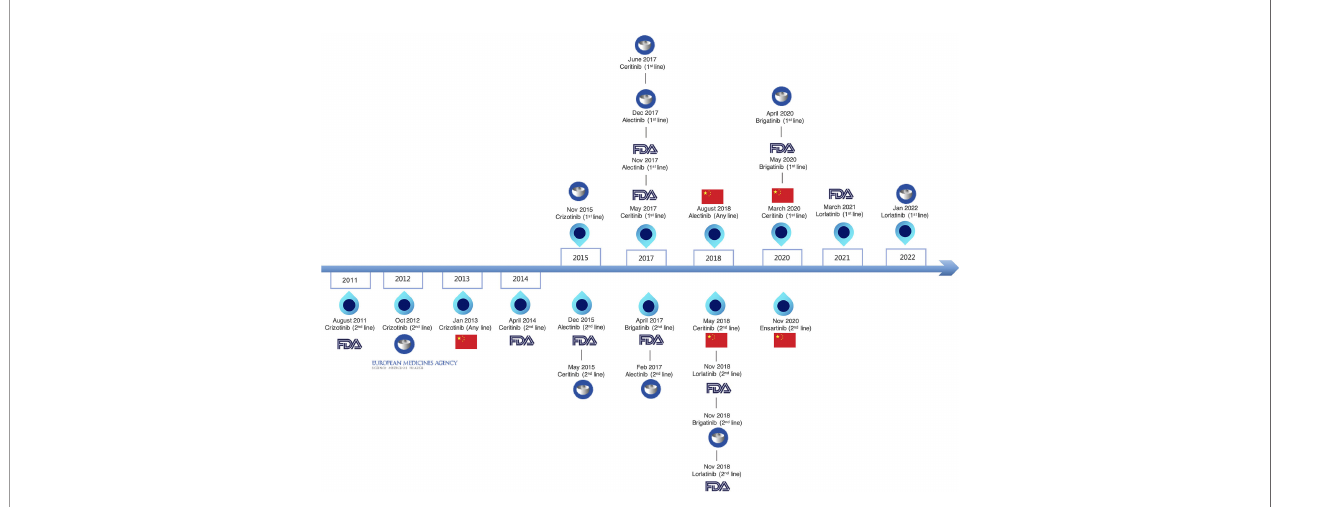
FIGURE 1 | Timeline of approved ALK